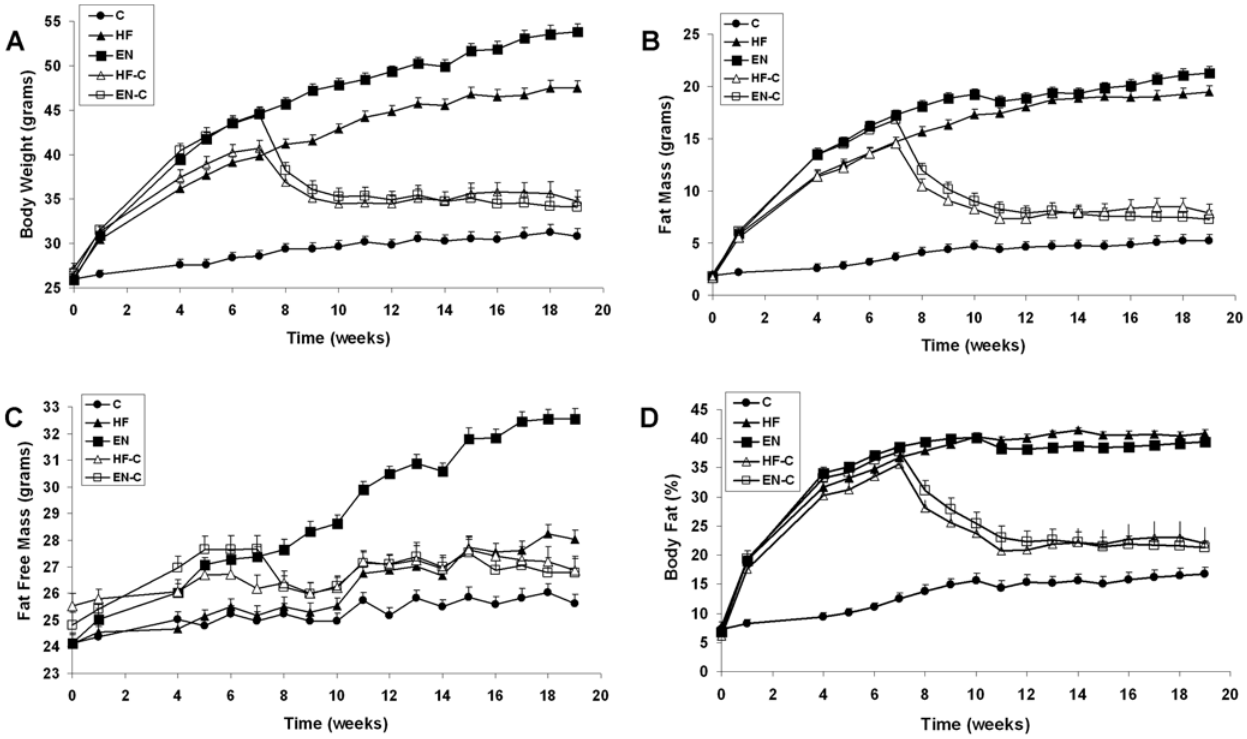
Figure 3. Body weight and body composition in male C57BL/6 mice from each group. Body weight (Panel A), fat mass (Panel B), fat free mass (Panel C), and percent body fat (Panel D) in male C57BL/6 mice from 5 diet groups: chow diet (C), high fat diet (HF), high fat diet plus Ensure H (EN), high fat diet for 7 wk followed by a switch to chow (HF-C), and high fat diet plus Ensure H for 7 wk followed by a switch to chow (EN-C). Values are mean 6 SEM and the error bars were often smaller than the size of the data point marker.